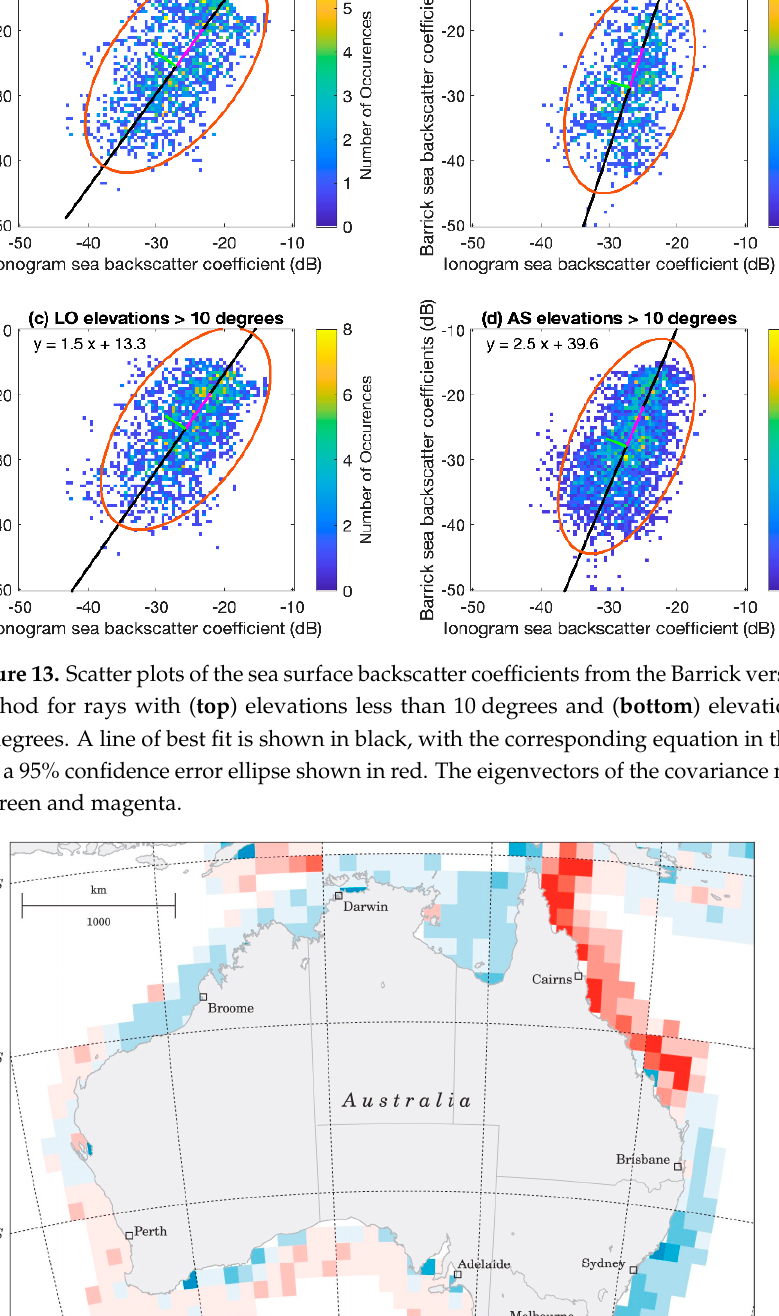
Figure 12. Histogram of the mean elevation of the rays reaching each range-azimuth cell for Alice Springs and Longreach in September 2015 and March 2016. The mean value is 12 degrees. Figure 13. Scatter plots of the sea surface backscatter coefficients from the Barrick versus the iono- gram method for rays with ( top ) elevations less than 10 degrees and ( bottom ) elevations greater than 10 degrees. A line of best fit is shown in black, with the corresponding equation in the top left corner and a 95% confidence error ellipse shown in red. The eigenvectors of the covariance matrix are shown in green and magenta.